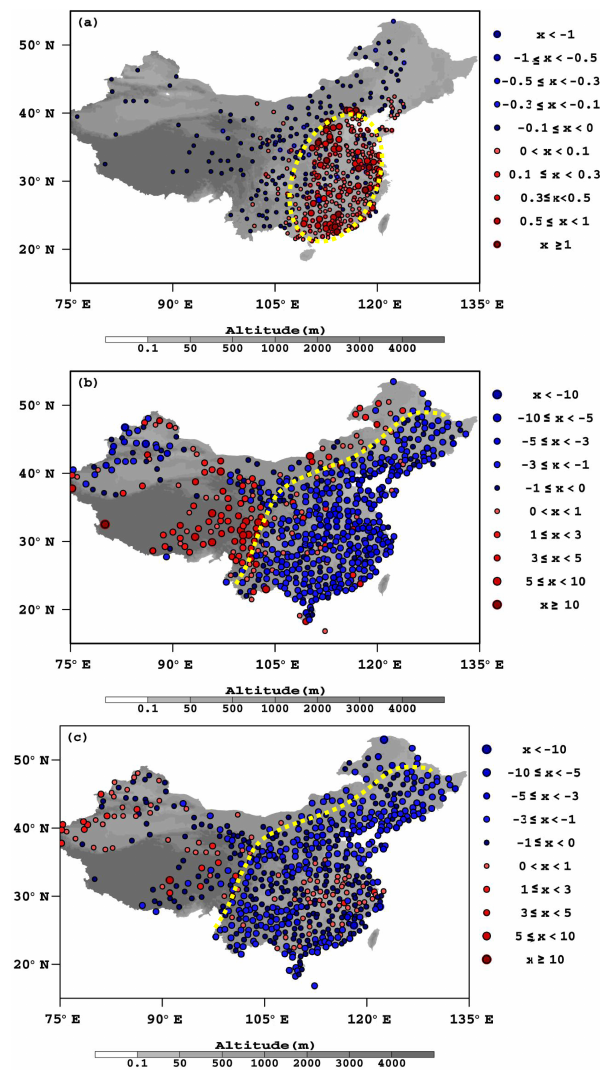
Figure 4. Distribution of interannual change trends (day per 10 years) in (a) haze frequency, (b) visibility and (c) light rain fre- quency in summer in mainland China in 1961–2010. The yellow dash lines mark the borders of frequent haze areas or the eastern borders of plateaus in